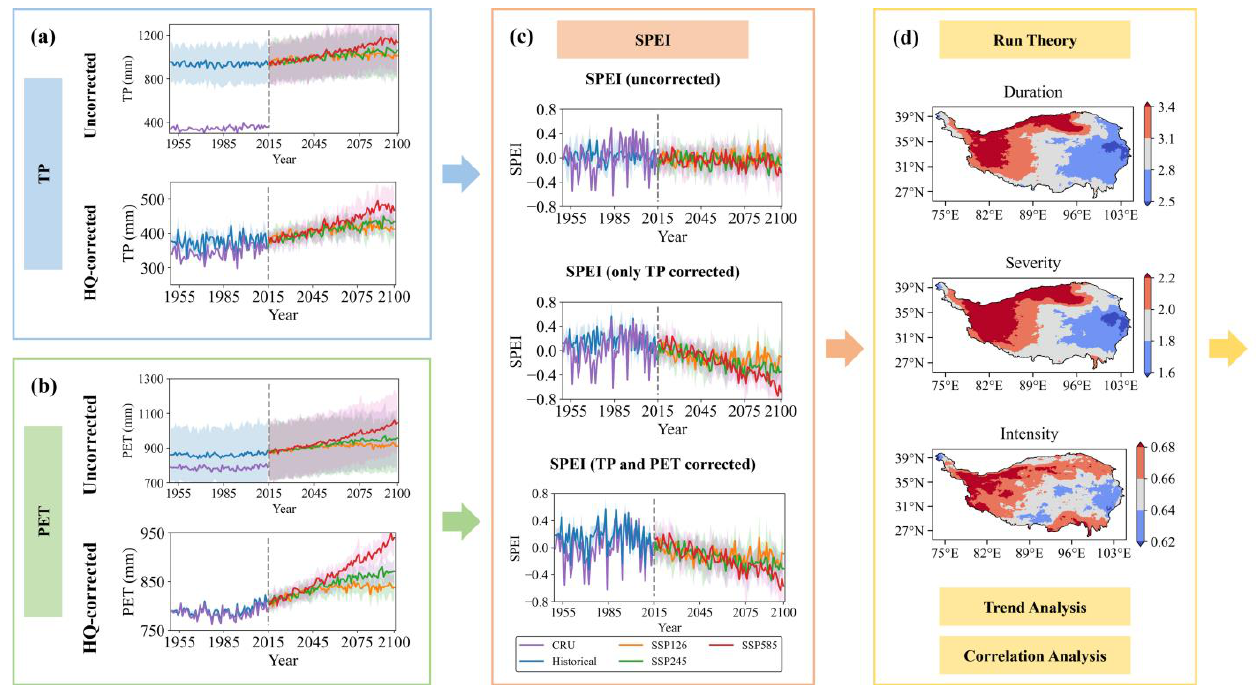
Figure 2. The overview of the proposed flowchart. ( a , b ) Change curve of annual TP and potential evapotranspiration (PET) with time before and after histogram matching-quantile mapping (HQ) correction. ( c ) Change curve of standardized precipitation evapotranspiration index (SPEI) with time before and after correction. ( d ) The research methods used in our research.